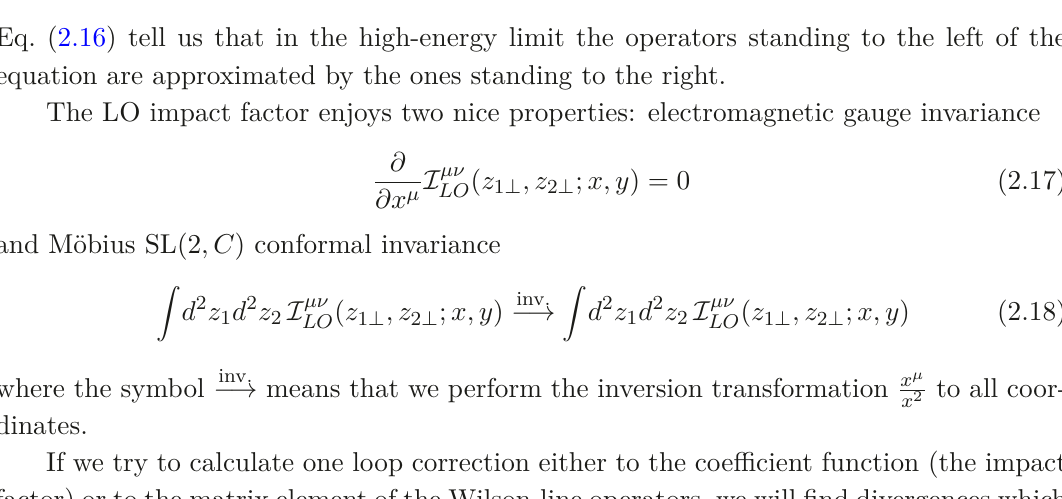
Figure 2 . Sample of diagrams (real ones) for the LO BK